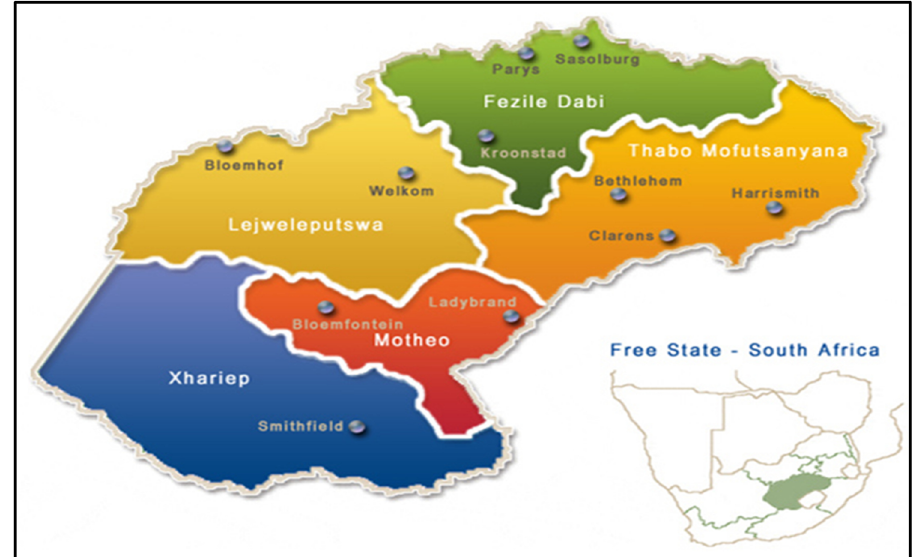
Figure 1: Map of the Free State Province showing its districts and the study area. Source: https://www.businessinsa.com/free -